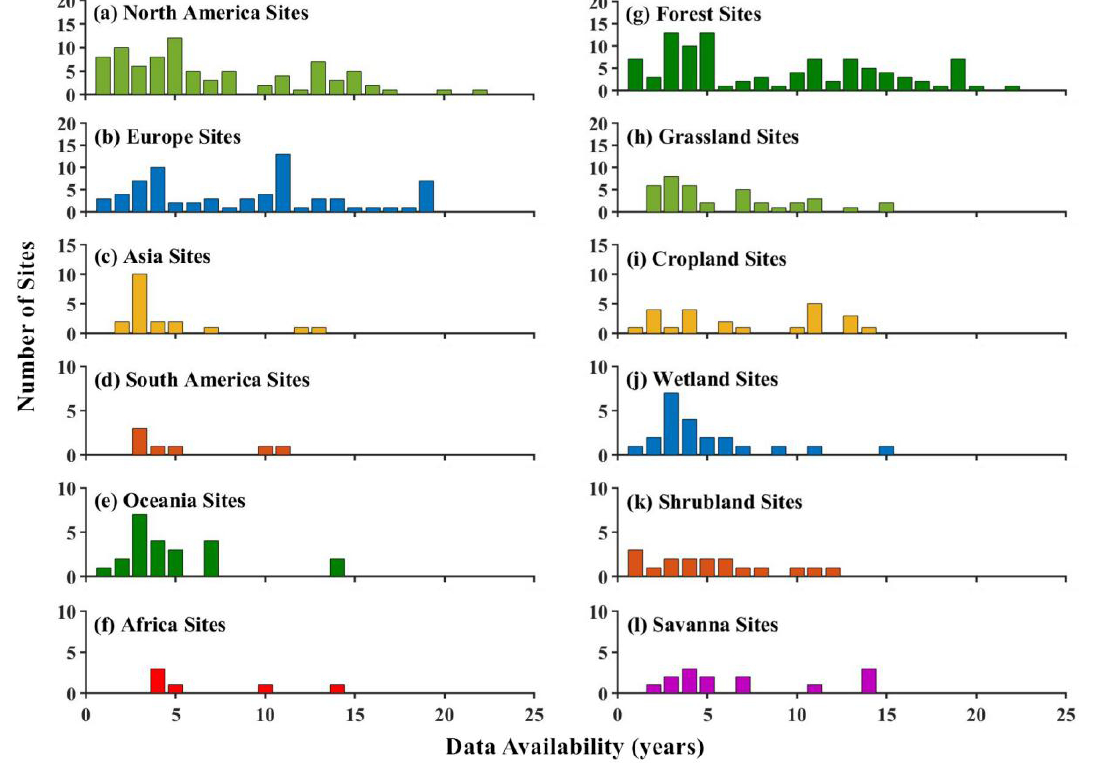
Figure 1. Data summary of the flux towers used in this